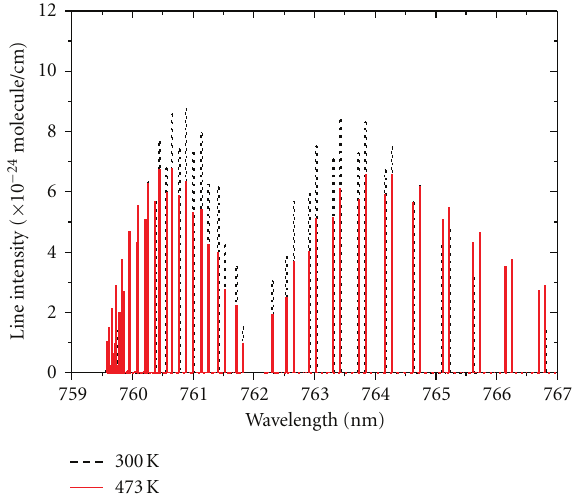
F 1: (Color online) absorption line intensity of oxygen around 760nm at 300 and 473K, respectively, according to HITRAN.